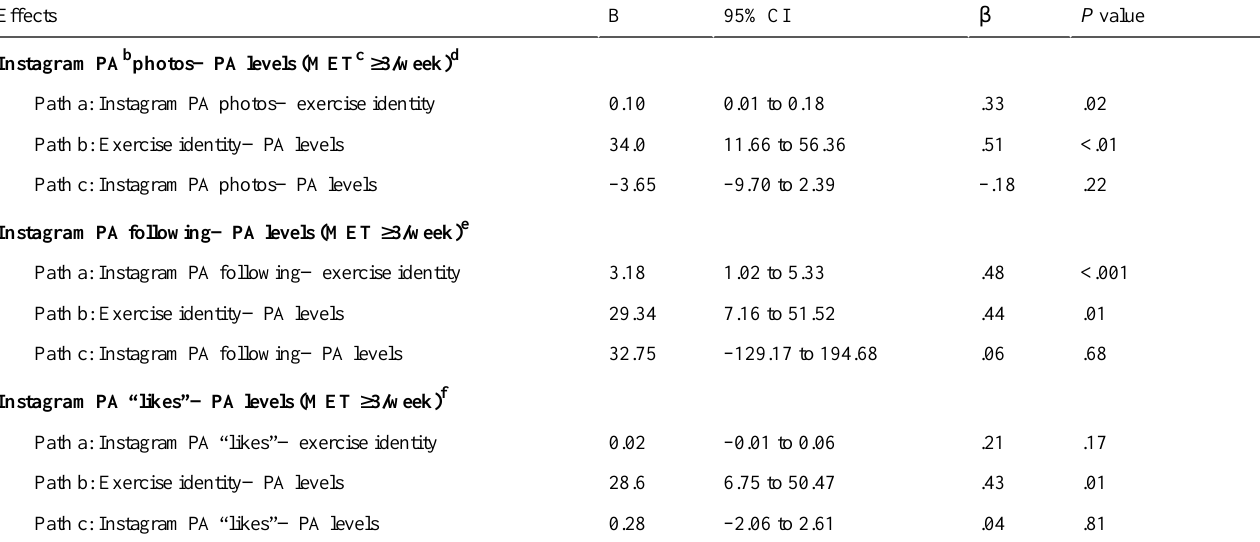
P value β 95% CIBEffects